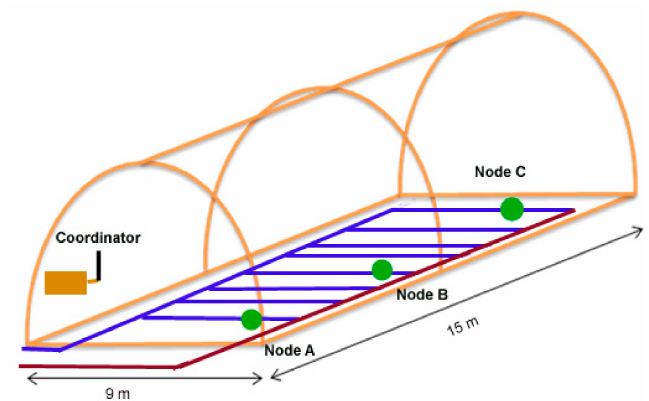
Figure 8. Experimental network setup in